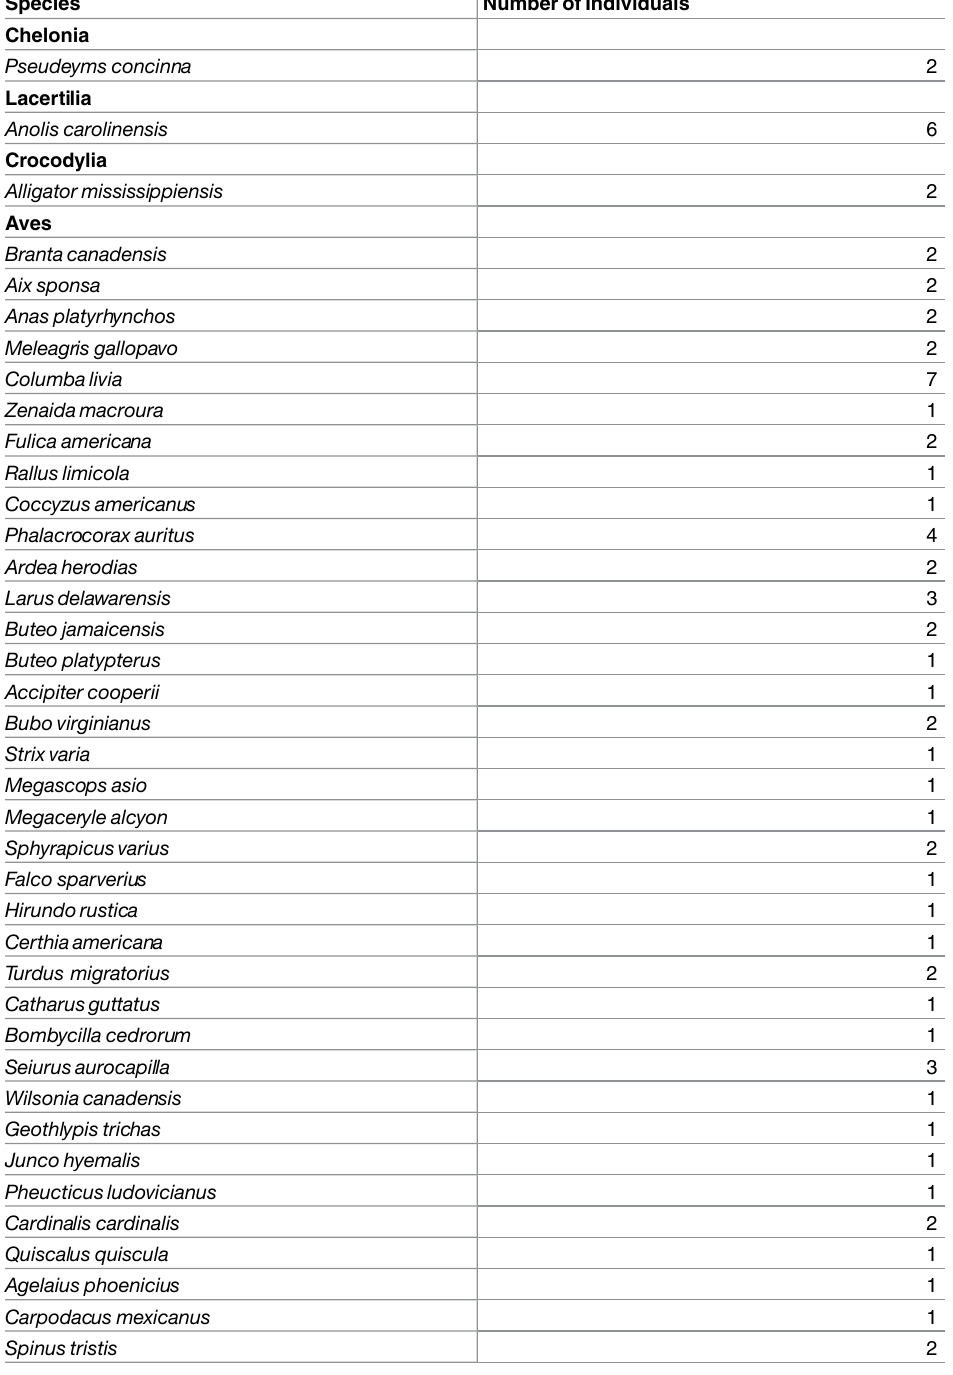
Table 1. Specimens